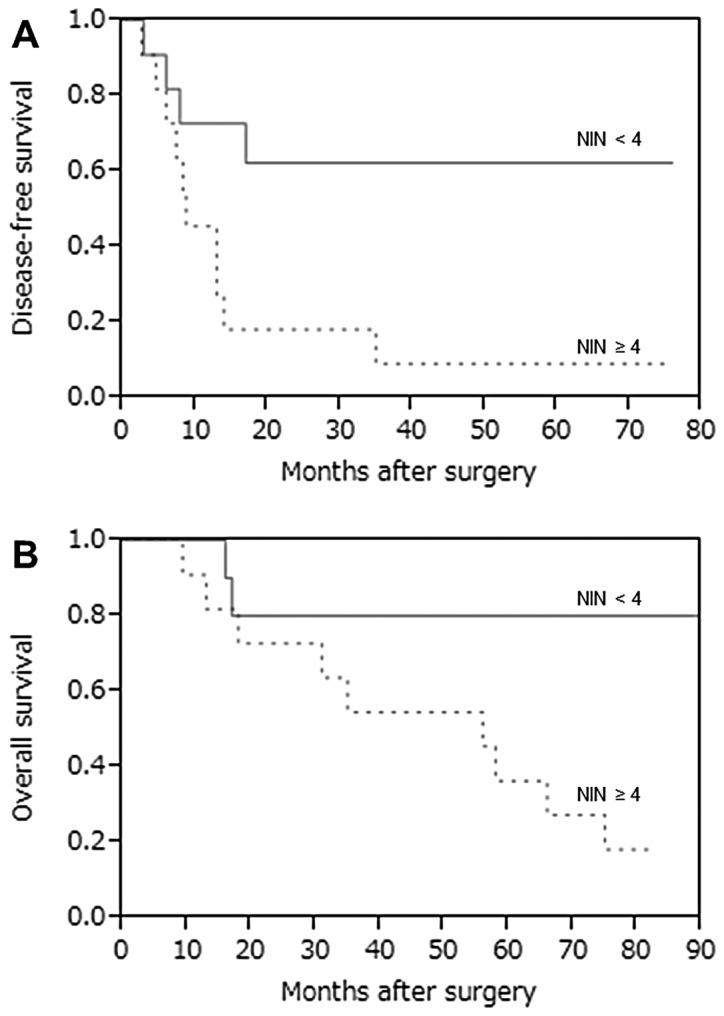
(A) Disease-free (DFS) and (B) overall survival (OS) curves for patients with different numbers of involved lymph nodes (NIN). A high NIN (≥4) was a significant prognostic factor correlated with DFS and OS (P=0.025 and P=0.024, respectively).